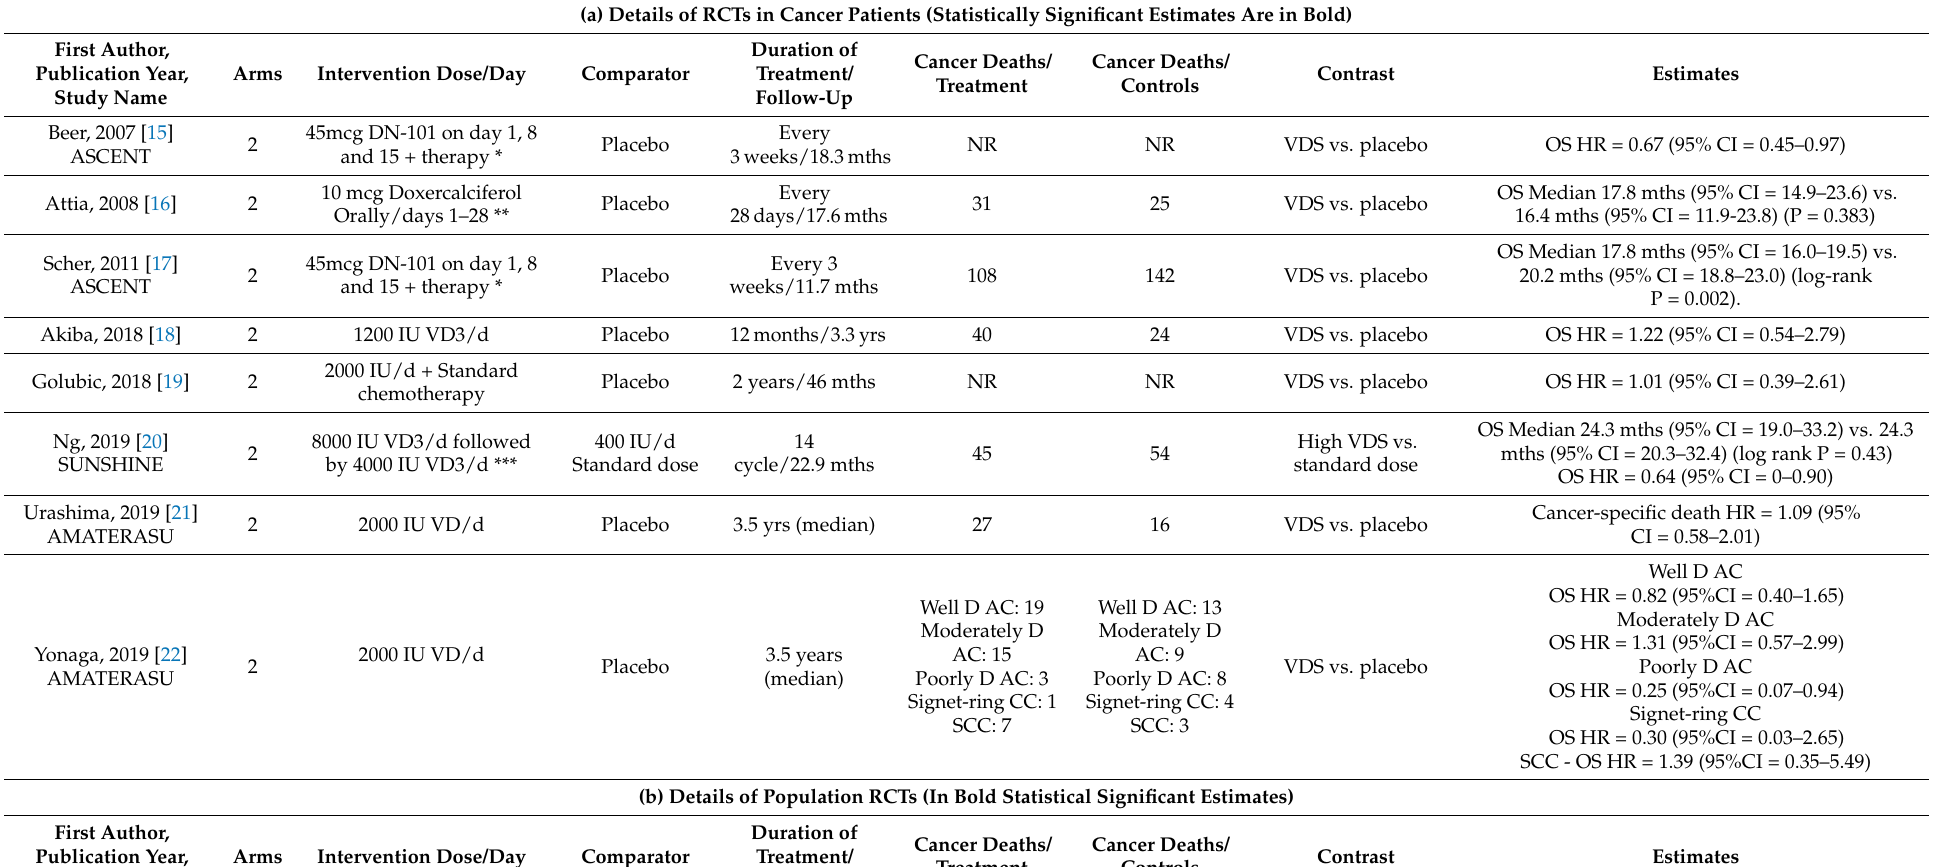
Table 2. Details of the included studies (statistically significant estimates are in